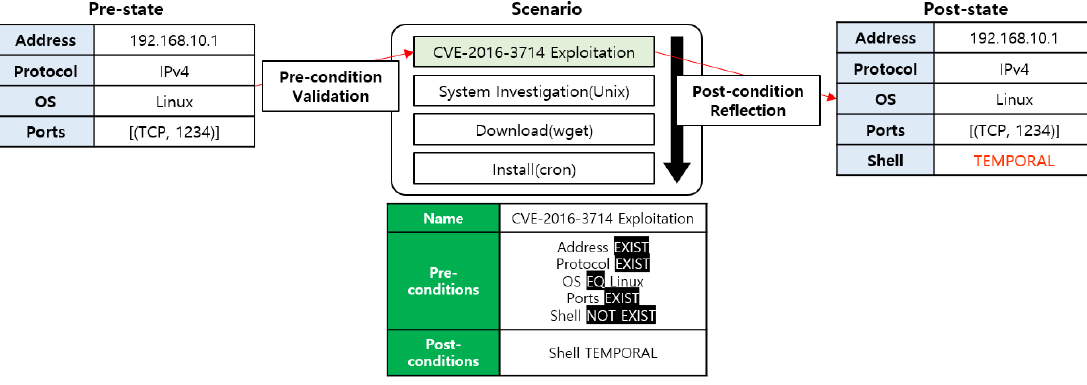
Figure 9. The example of the process of scenario performance: CVE-2016-3714 exploitation.